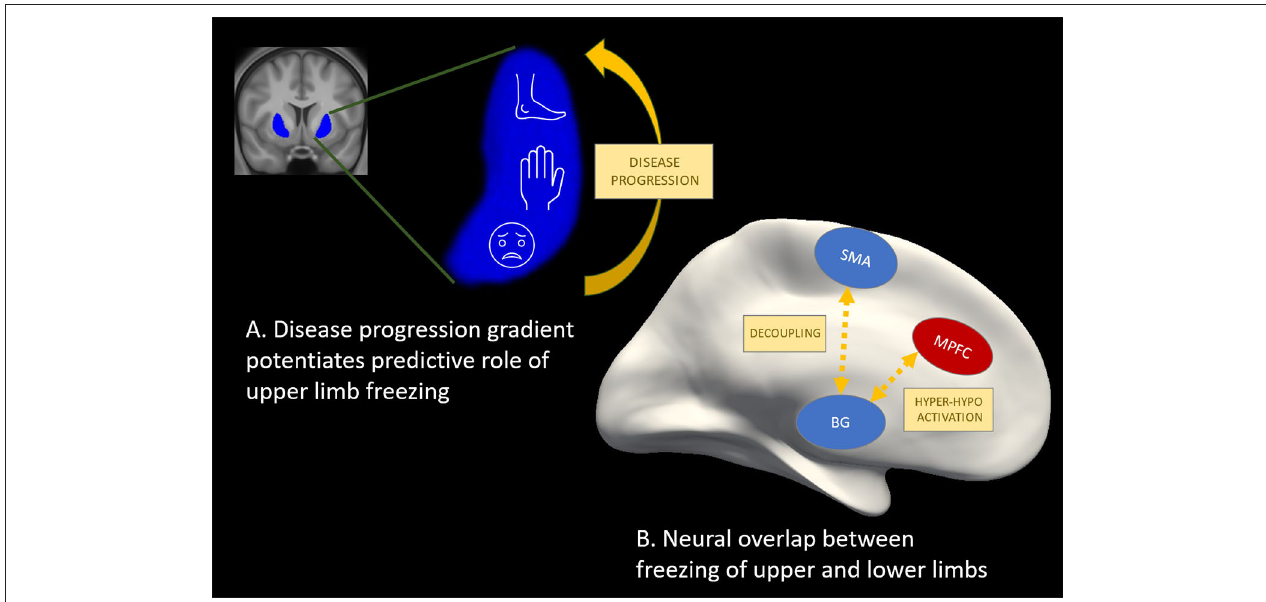
FIGURE 1 | Potential for other effectors as valid markers of freezing of gait. (A) The motor representation in the putamen (Nambu, 2011) (in blue) aligns with the gradient of dopaminergic loss in the putamen (Kish et al., 1988) (from caudal to rostral) such that the face and upper limbs are affecter earlier, potentiating predictive utility of upper limb freezing. (B) Hyper-activation (in red) and hypo-activation (in blue) in cortical and sub-cortical regions as well as desynchronization or decoupling between these regions has been shown during freezing episodes in finger tapping ( Vercruysse et al., 2014b; Brugger et al., 2020), foot pedaling (Shine et al., 2013a,b; Matar et al., 2019 ), and during real gait (Pozzi et al., 2019) studies. These findings point to a common neural mechanism underlying freezing in gait and non-gait effectors, which is promising for future work aiming to further explore freezing mechanisms as well as therapeutic effects on the freezing